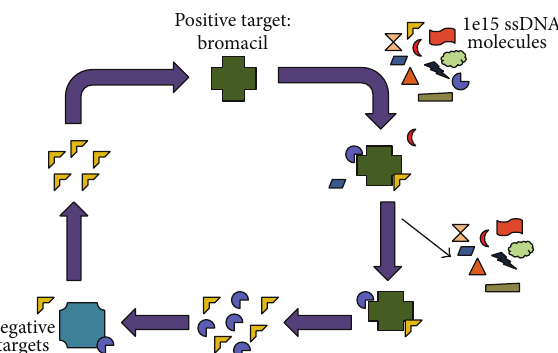
Figure 1: Scheme depicting the SELEX process. The target bromacil is incubated with a library of 10 15 ssDNA molecules. Those that bind are amplified and incubated with multiple negative targets. Those that do not bind the negative targets are amplified and subjected to additional rounds of in vitro